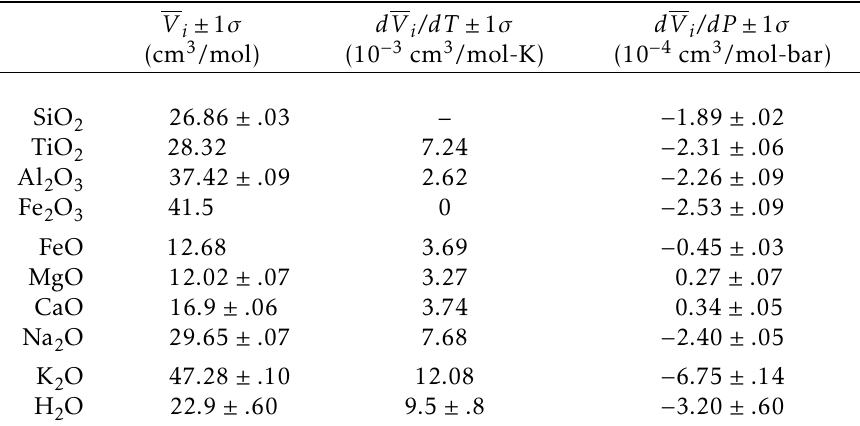
Table 1 – Partial molar volumes and pressure and temperature derivatives for each oxide